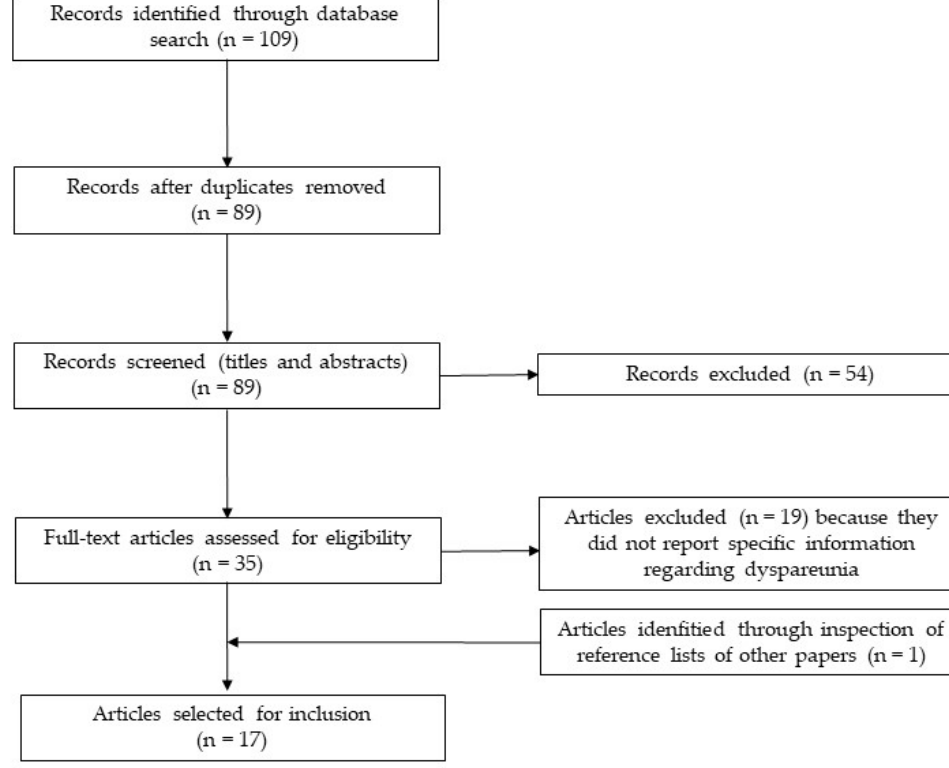
Figure 1. Selection process flowchart.